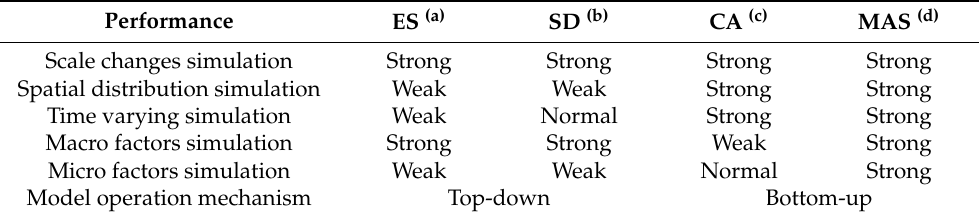
Table 1. Performance comparison of current models for urban spatial evolution simulation. Performance ES (a) SD (b) CA (c) MAS (d) Scale changes simulation Strong Strong Strong Strong Spatial distribution simulation Weak Weak Strong Strong Time varying simulation Weak Normal Strong Strong Macro factors simulation Strong Strong Weak Strong Micro factors simulation Weak Weak Normal Strong Model operation mechanism